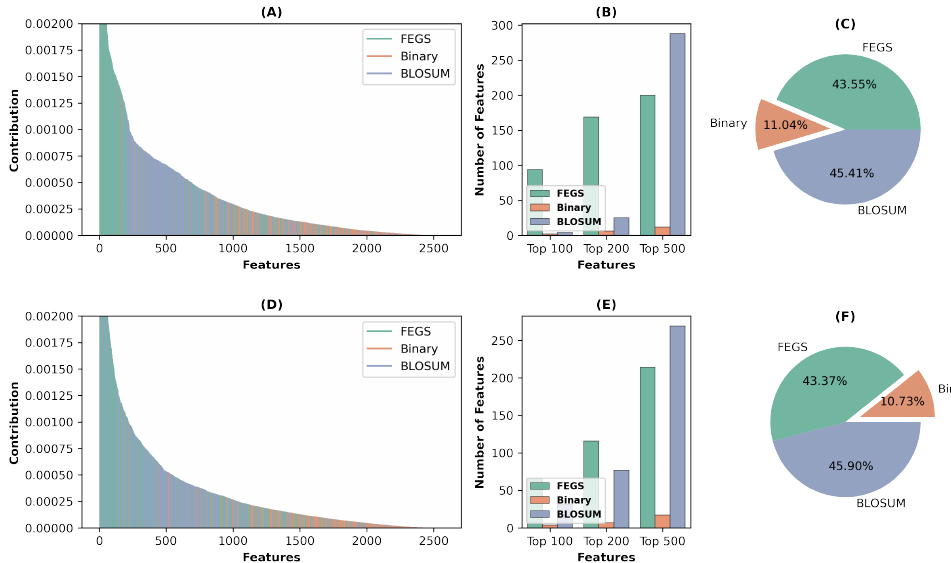
Figure 3. Feature analysis on two datasets. ( A , D ) Visualize the three types of features on Set 1 and Set 2 in descending order of their contribution. Green, orange, and blue indicate features in FEGS, Binary profile, and BLOSUM62, respectively. ( B , E ) Illustrate the numbers of the top 100, 200, and 500 features on Set 1 and Set 2. ( C , F ) Show the proportion of the total contribution of the three types of